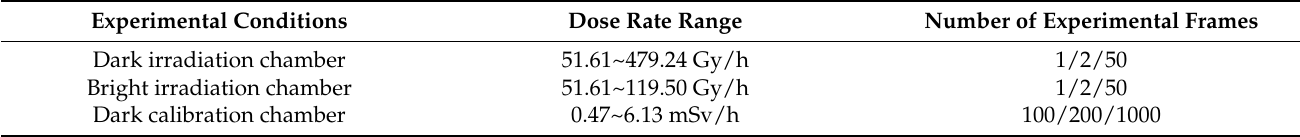
Table 3. Experimental scheme of convergence efficiency of